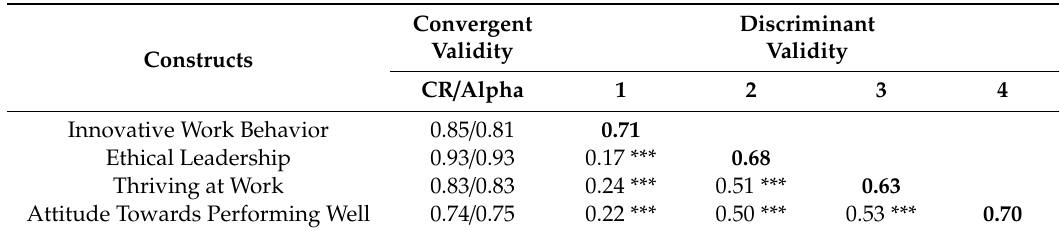
Table 2. Validity of the